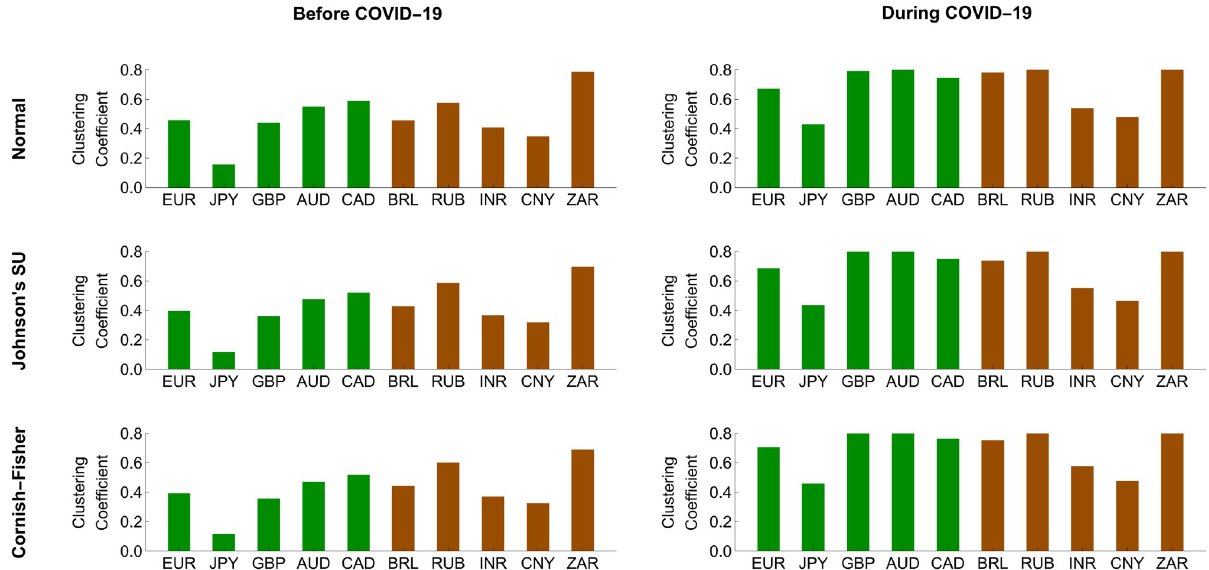
Fig 10. Node clustering coefficients of conditional tail risk networks based on Δ CoVaR forecasts. Green and brown represent the advanced and emerging forex markets, respectively.